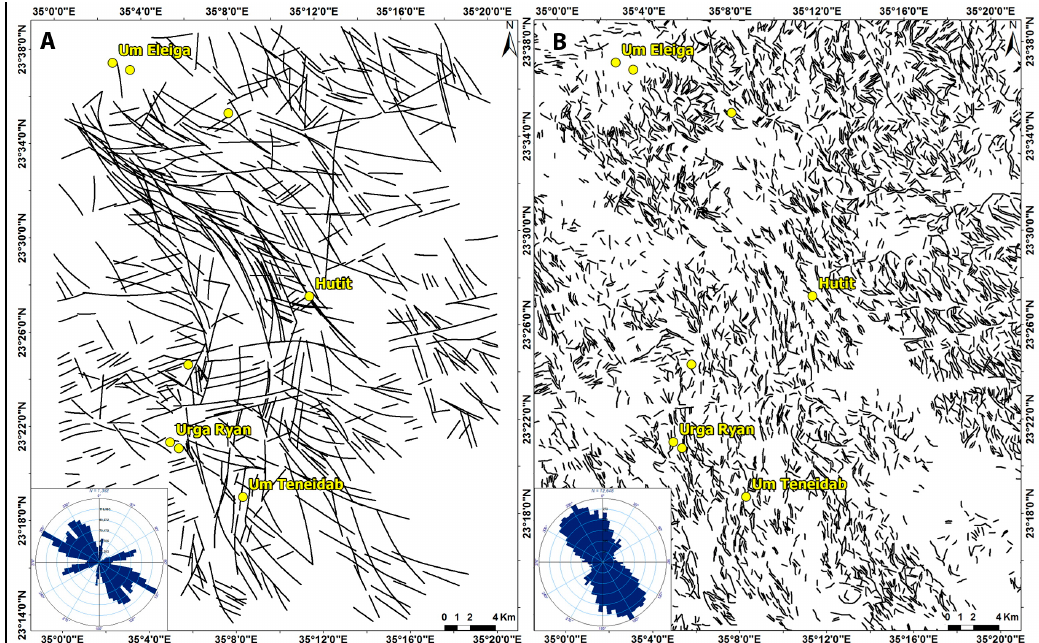
Figure 9. Geological lineament extracted from the SAR data of the study area. ( A ) Manually extracted lineaments aided by edge enhancement techniques of PALSAR and Sentinel-1 PCA images verified in the fieldwork; ( B ) results of the automated lineament extraction technique (ALE) using the same images as in Figure 8 after applying the directional filters. Insets are rose diagrams showing the main structural trends in the study area. The manually extracted lineament results obviously show the two main northwest (NW)–southeast (SE) and north-northwest (NNW)–south-southeast (SSE) structural trends, whereas the automated extraction shows only the prevailing NNW–SSE trend.